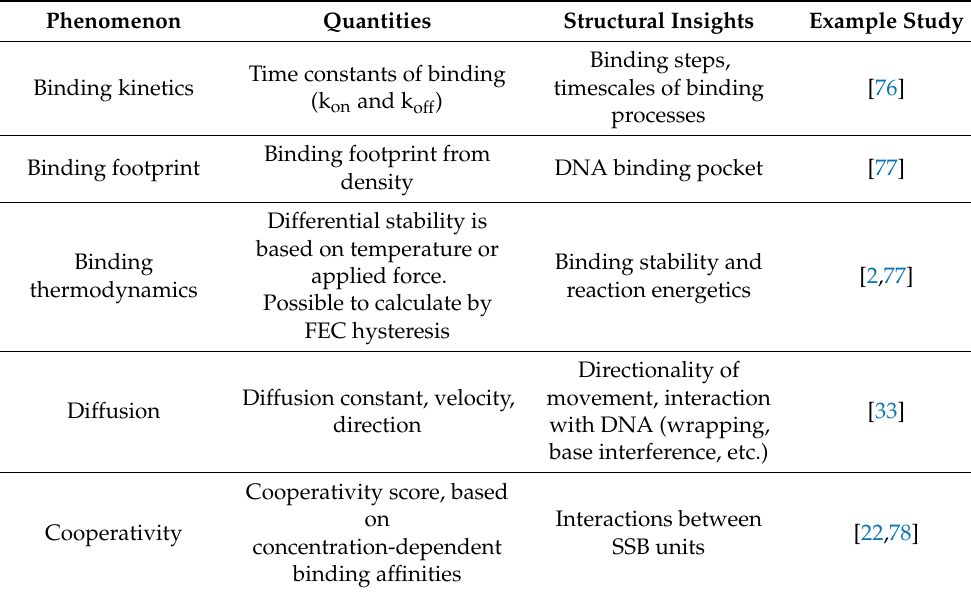
Table 1. Example output of single-molecule